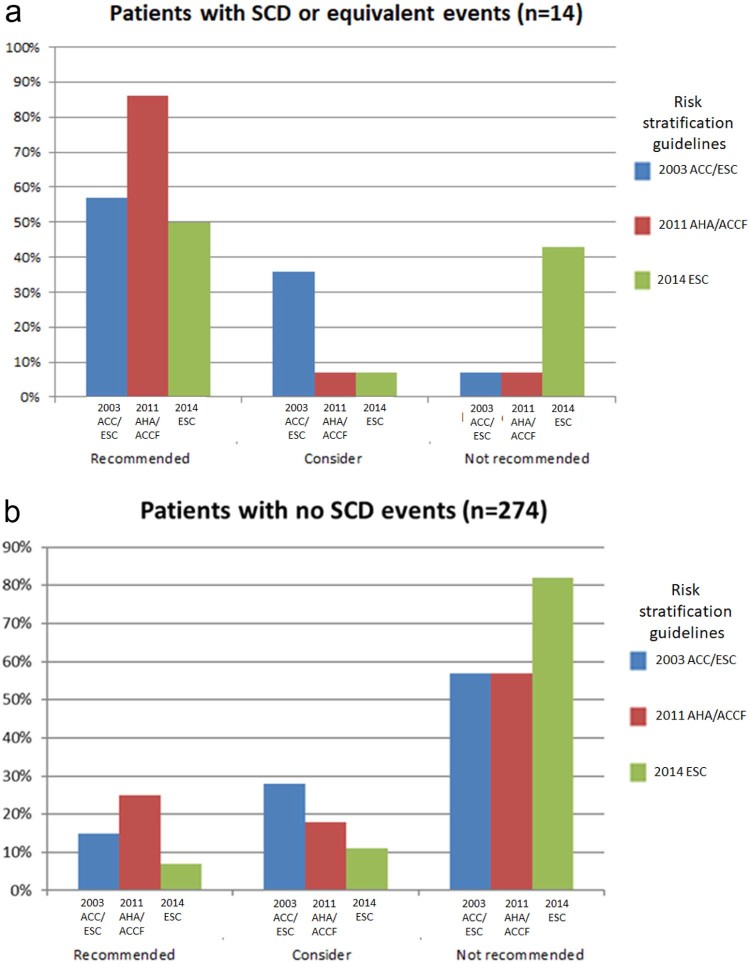
Proportion of patients grouped according to ICD recommendations by the 2014 (green), 2011 (red), and 2003 (blue) models in the sudden cardiac death group (A) and non-sudden cardiac death group (B). ACC = American College of Cardiology; ACCF = American College of Cardiology Foundation; AHA = American Heart Association; ESC = European Society of Cardiology. (Color version available online.)